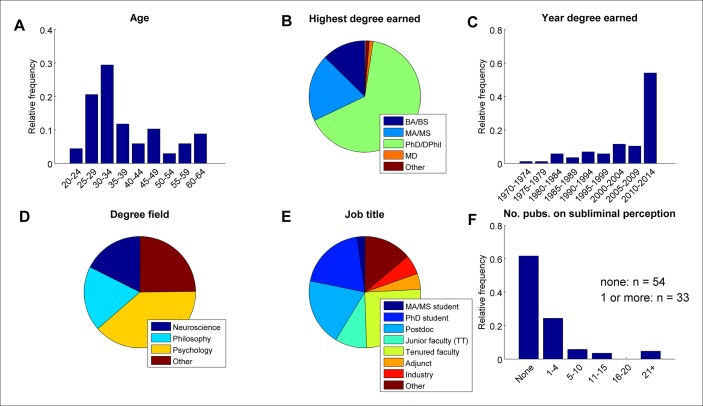
Demographics of survey respondents (n = 87).